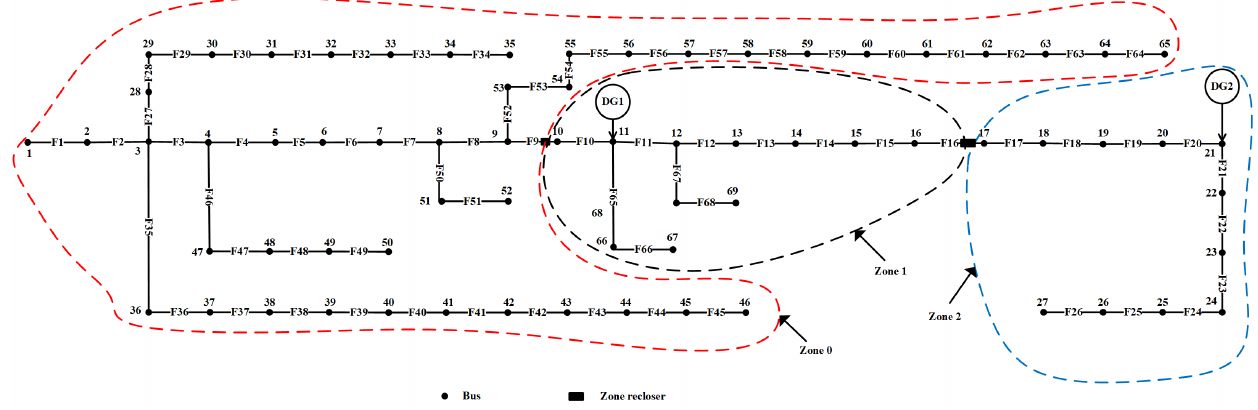
Figure 5. Zonesformation of 69-bus RDS per the average values of load and DG generations.